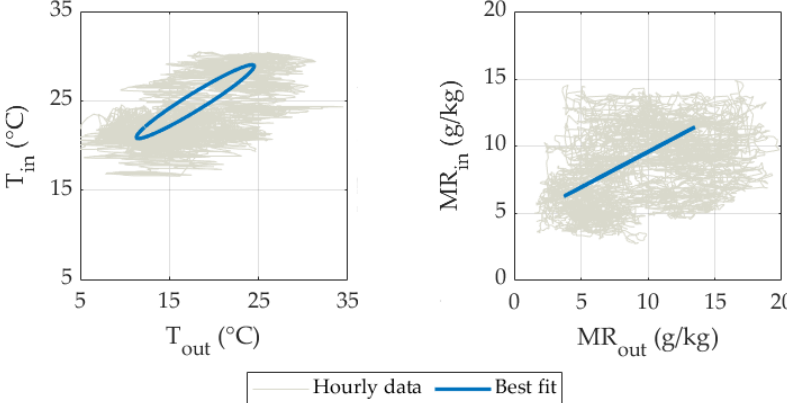
Figure 6. Indoor versus outdoor temperature ( left ) and mixing ratio ( right ) daily data over the solar year monitored (grey dots). The best fit lines (in blue) describe the yearly cycle inside the building.